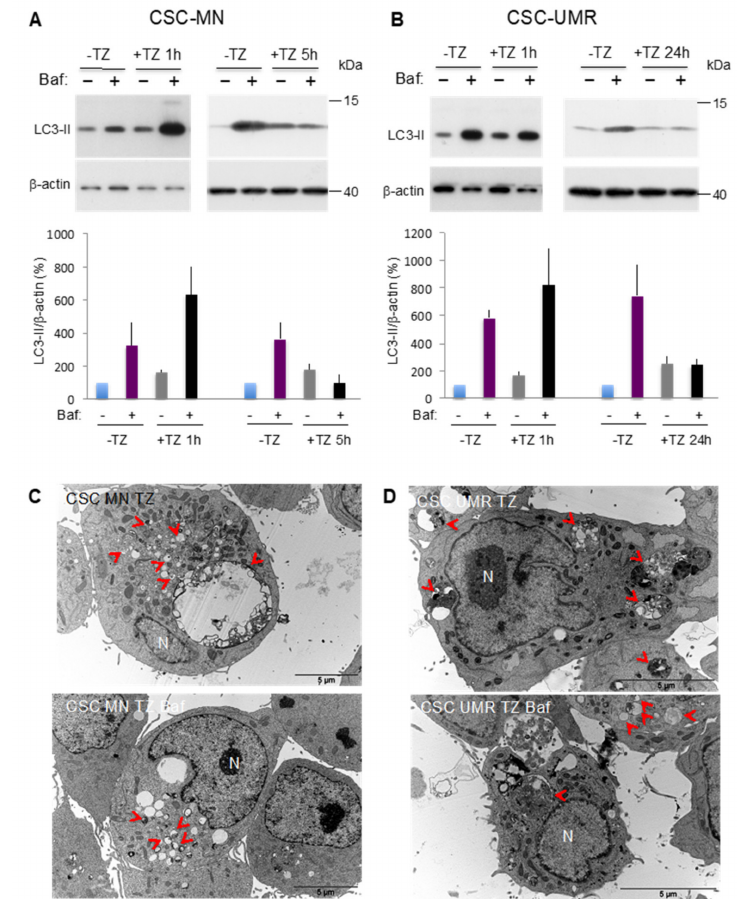
Figure 5. Thioridazine (TZ) modulates the autophagic pathway ultimately leading to autophagic flux impairment in OS CSC-enriched populations. ( A , B ) Western blot analysis of the LC3-II protein xpression performed in the absence (-) or in the presence ( + ) of Baf and TZ at sub-toxic concentration (8 µ M) for a short (1 h) or longer (5 h or 24 h for the MN or the UMR cell line, respectively) time.